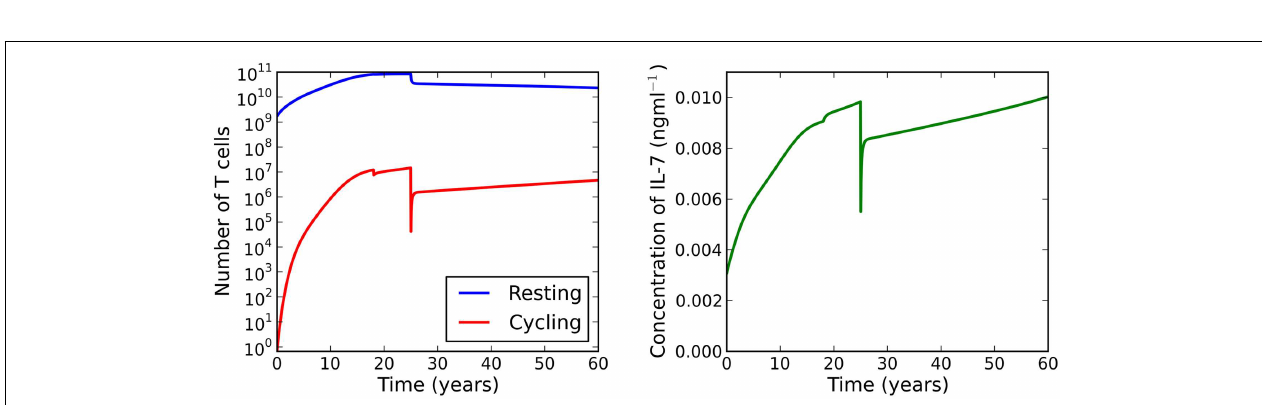
FIGURE 8 |At age 18 the individual experiences some event resulting in impaired cell cycle progression . At age 25 the individual undergoes treatment to limit IL-7 production to levels comparable to those at 11years of